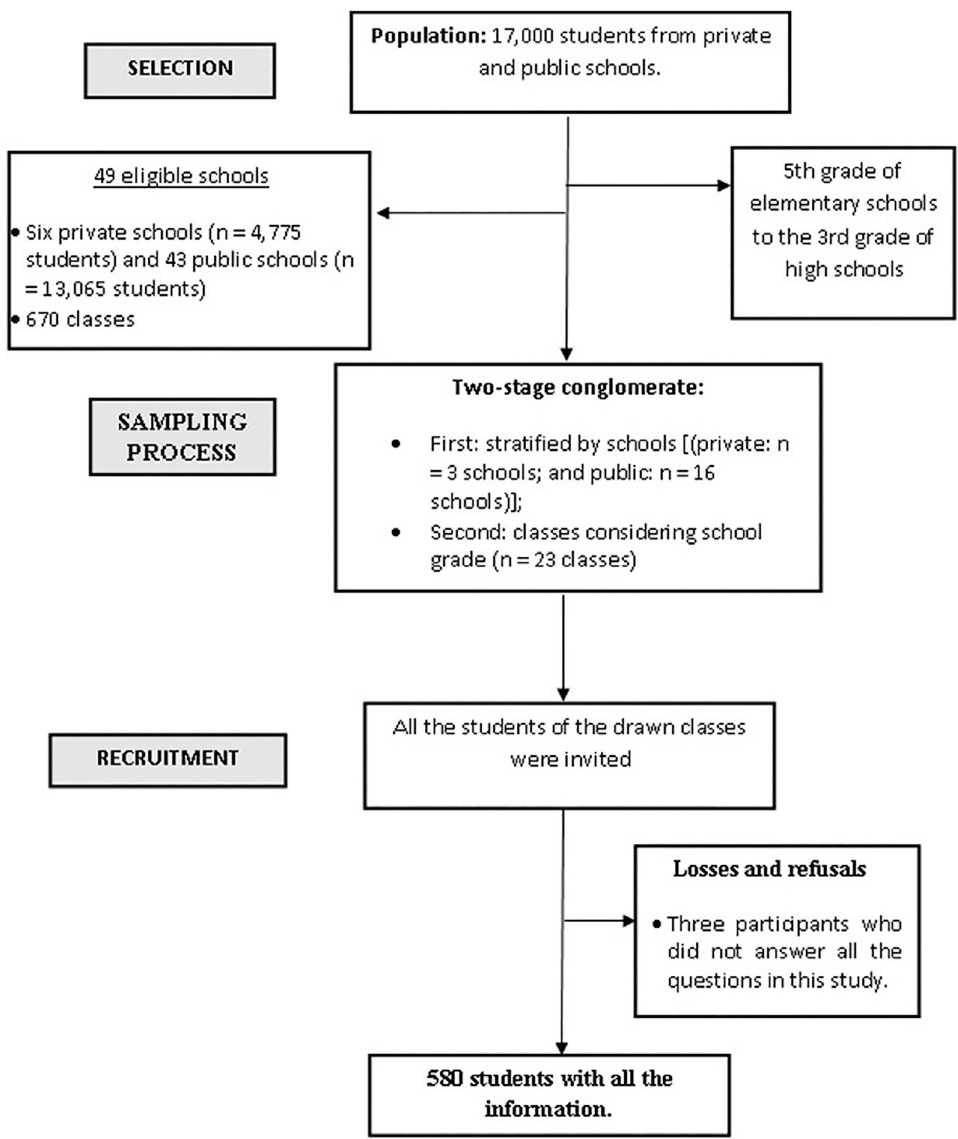
Figure 1 - Flowchart of the sampling process adopted in the present